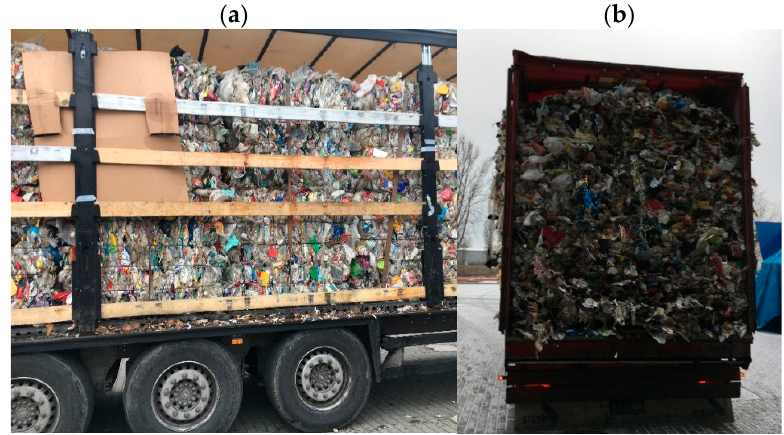
Figure 3. Transportation of mixed municipal waste to the plant.